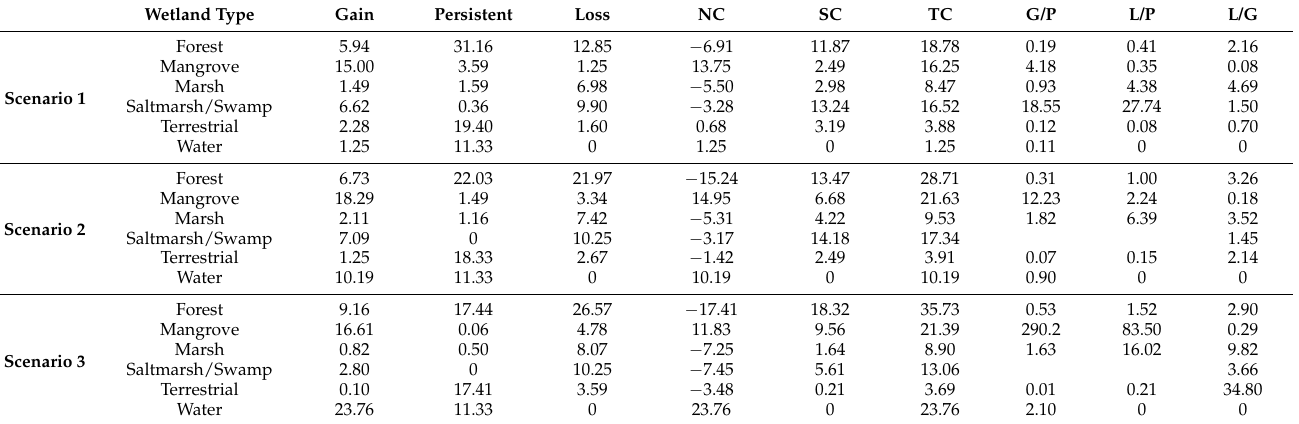
Table 2. The land-cover transitions for the focused study area in the Manning River Estuary under three sea level rise scenarios (SLR scenarios 1, 2, and 3 correspond to 0.5 m, 1.0 m, and 1.5 m SLR, respectively). The change percentages associated with each class are proportions of the total area shown in Figure 3.